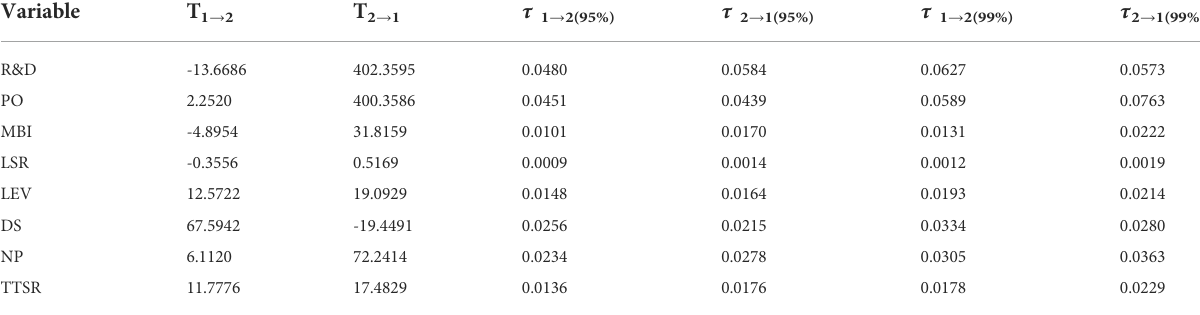
TABLE 11 Results of information fl ow.